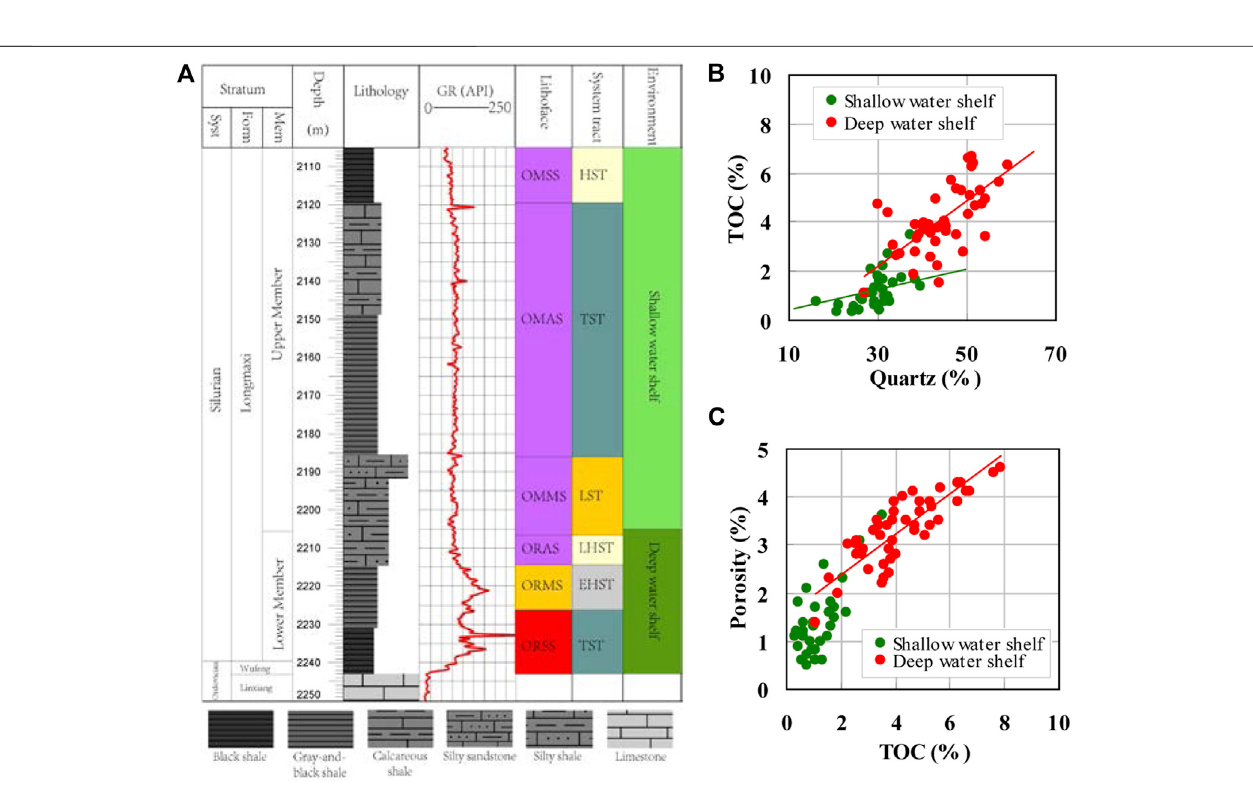
Frontiers in Earth Science |